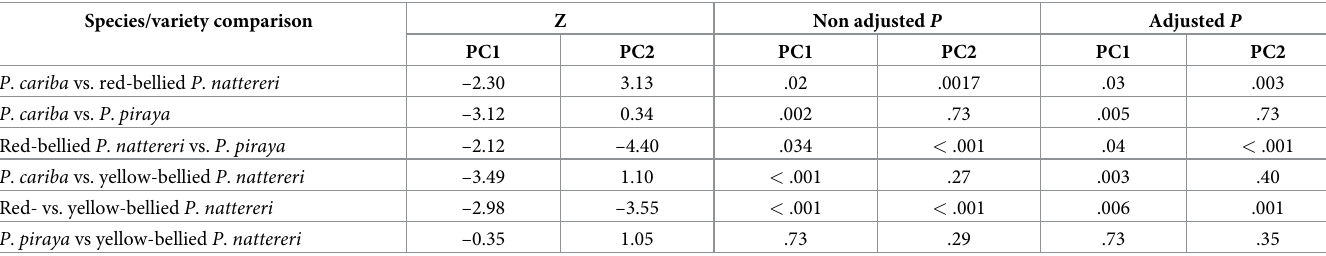
Table 3. Scores of the Dunn post-hoc test on the principal components. Significant P -values in red. Species/variety